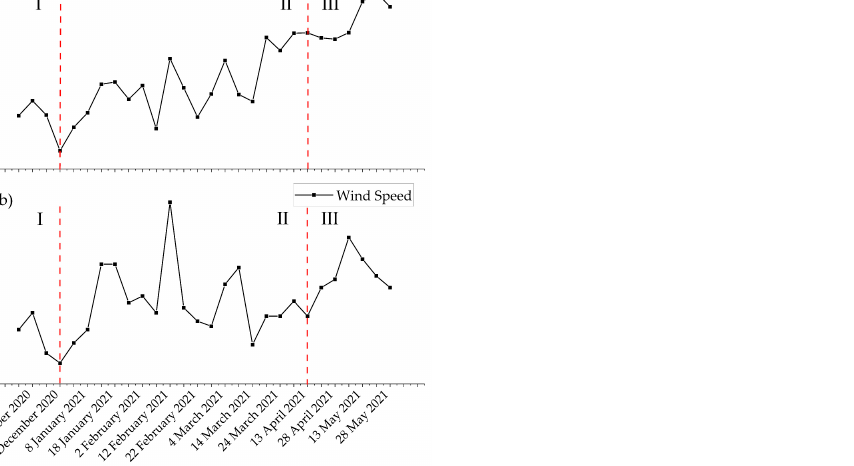
Figure 2. Weather data collected from NOAA’s stations for Lake Khovsgol from December 2020 to June 2021. ( a ) Air temperature data; ( b ) wind speed data.